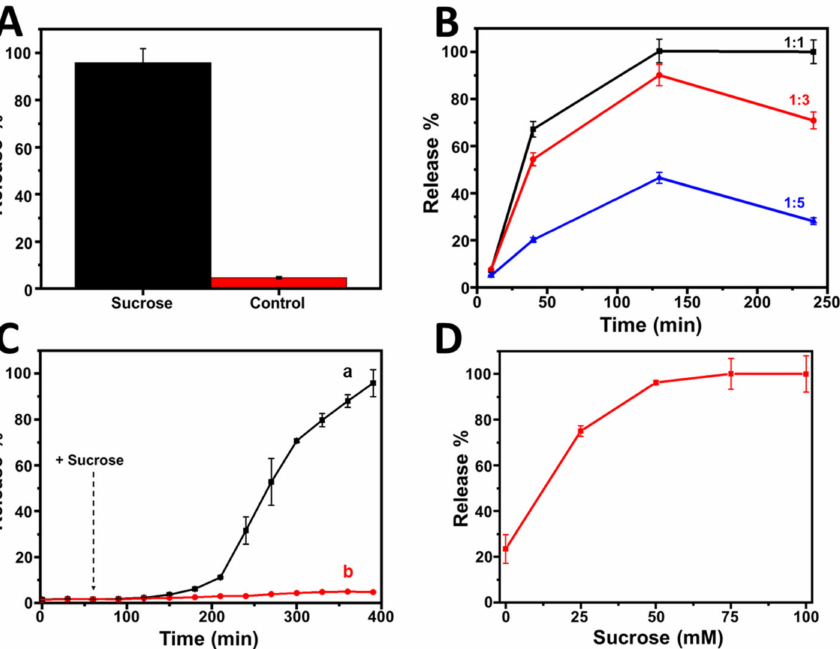
Figure 4. Sucrose-responsive interaction between Janus nanoparticles: ( A ) % of [Ru(bpy) 3 ] 2+ release encapsulated in J1c because of the interaction between Jc1c and Jc2c after 100 min of sucrose (50 mM) addition. ( B ) Kinetics of [Ru(bpy) 3 ] 2+ release encapsulated in J1c for different proportions of J2c in the presence of 50 mM of sucrose. ( C ) Kinetics of [Ru(bpy) 3 ] 2+ release encapsulated in J1c because of the interaction between J1c and J2c after the addition of 50 mM of sucrose. ( D ) % of [Ru(bpy) 3 ] 2+ release encapsulated in Jc1c because of the interaction between J1c and J2c at different sucrose concentrations (t = 6h). (Conditions: 20 mM Na 2 SO 4 , pH 7.5, 25 ◦ C, [J1b] = 3 mg mL − 1 , [J2b] = 3 mg mL − 1 , λ abs = 454 nm). Error bars correspond to the s.d. from three independent